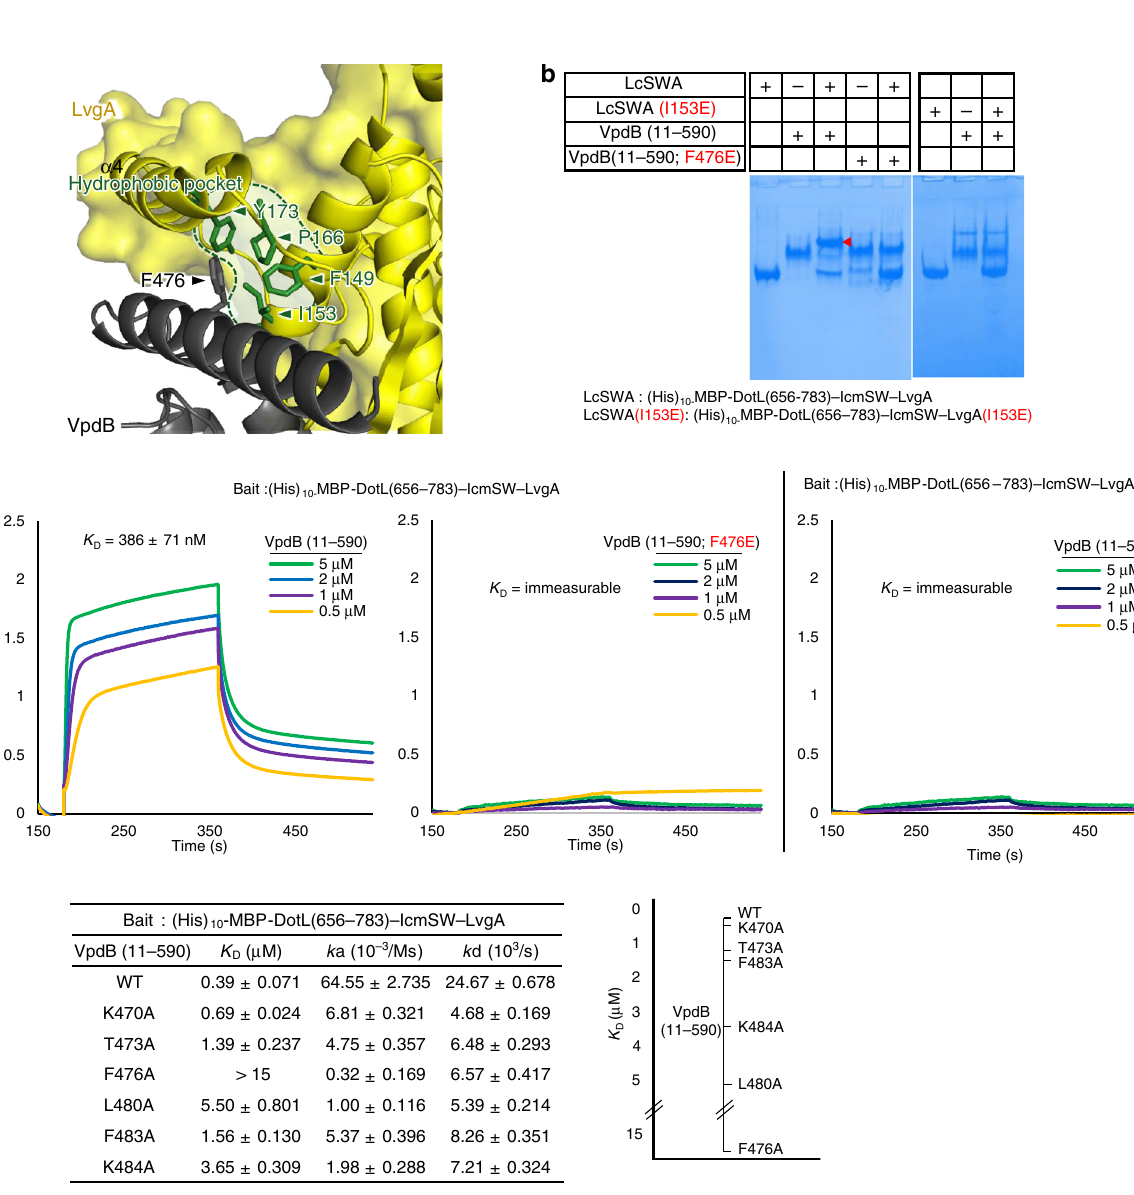
Fig. 1 Crystal structure of DotL(656-783) – IcmSW – LvgA – VpdB(461-590). a VpdB(461-590) binds to (His) 10 -MBP-DotL(656-783) – IcmSW – LvgA. Each of the fi ve truncated VpdB proteins (10 μ M) was incubated with (His) 10 -MBP-DotL(656-783) – IcmSW – LvgA at a 1:1 molar ratio and visualized on a native PAGE-gel by Coomassie staining. Schematic drawings of the constructs of VpdB are shown on the left. The black brackets and the red arrowheads indicate the diffusive input protein bands and newly formed protein bands, respectively. The dotted line indicates the borderline between the stacking and the running gel. b Two views of structure of the DotL(656-783) – IcmSW – LvgA – VpdB(461-590). Schematic drawings of the fi ve protein constructs are shown at the top. Protein constructs used for structure determination are color coded and labeled. c Enlarged view of the interaction between VpdB(461-590) and LvgA. α 1 of VpdB(461-590) lies on a wide and shallow groove of LvgA. VpdB residues majorly involved in the intermolecular interaction are shown as sticks. d Helix α 1 is the major binding motif. (His) 10 -MBP-DotL(656-783) – IcmSW – LvgA (10 μ M) was incubated with CPD-(His) 10 tagged helix α 1 or (His) 10 -MBP tagged four-helix bundle α 2 – α 5 of VpdB(461-590) at a 1:1 molar ratio, and visualized on a native gel. Only helix α 1 exhibited a newly formed protein band indicated by the red arrowhead. All the native PAGE analyses were repeated more than 3 times.